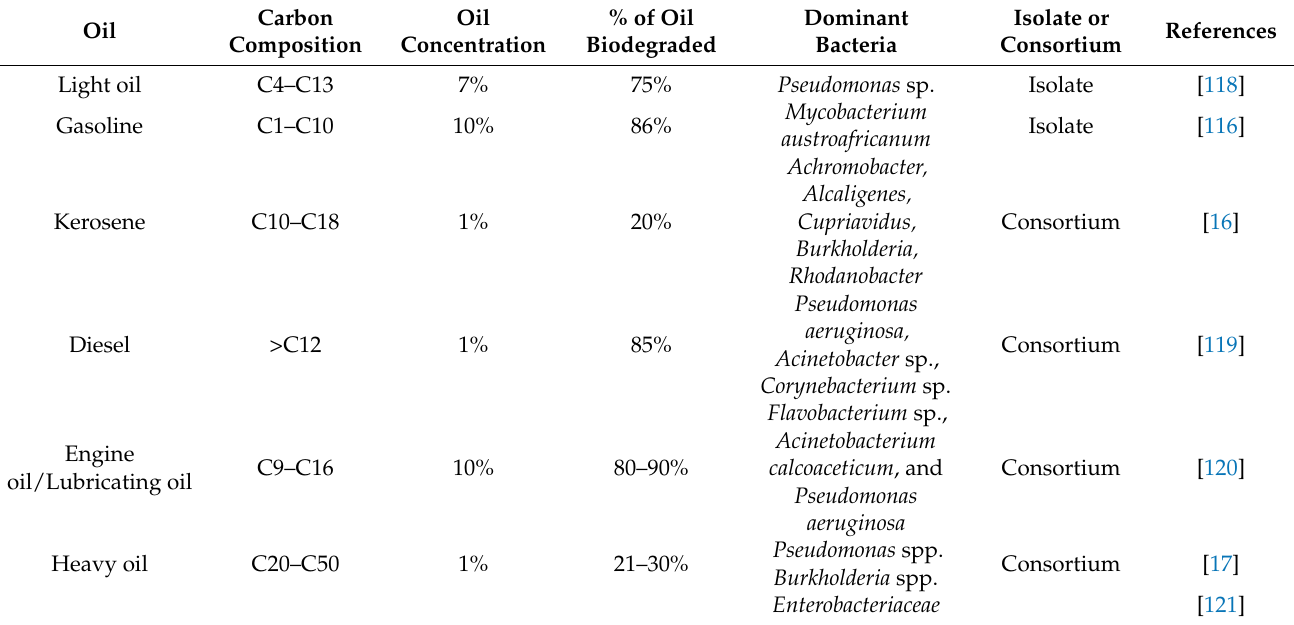
Table 2. Major classifications of spilled oil and corresponding valuable biodegrading